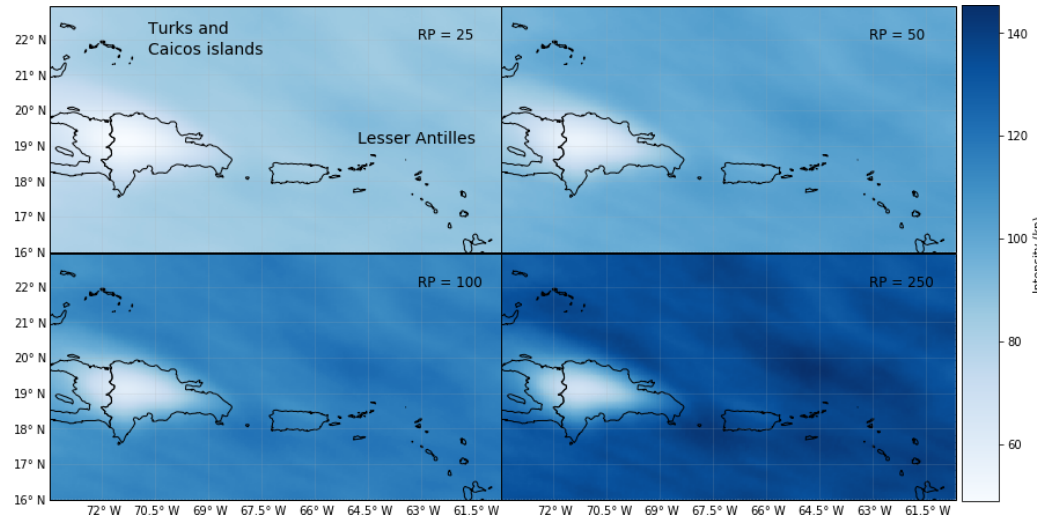
Figure 5. Wind fields in knots for return periods (RPs) of 25, 50, 100, and 250 years in the study region.